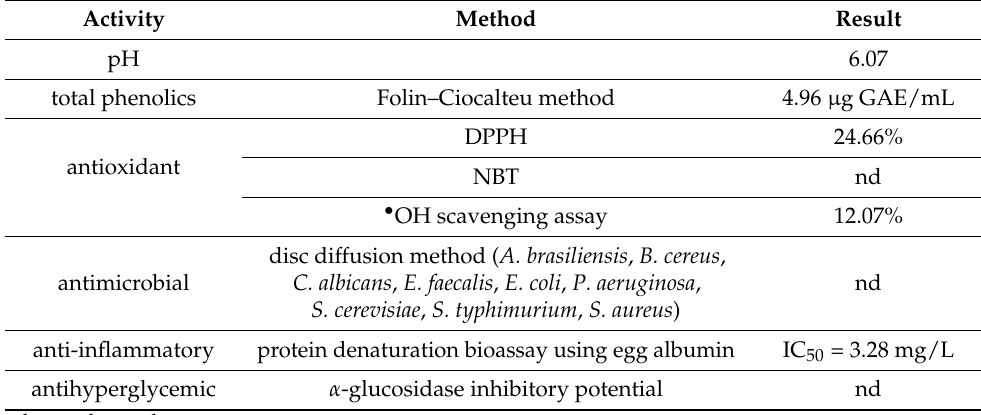
Table 3. pH value, total phenolic content, and biological activities of R. hybrida hydrosol.